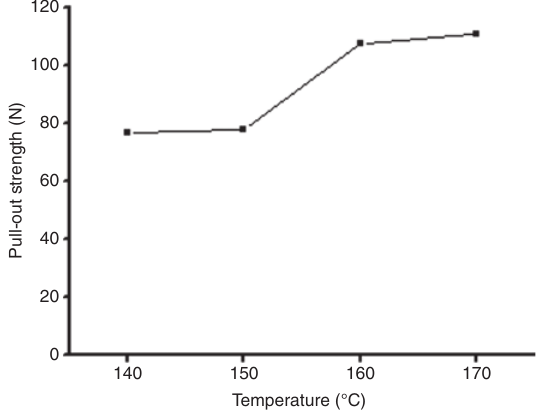
Figure 1: Pull-out curve of tire cord-reinforced CR with various vulcanization temperatures for 30 min.